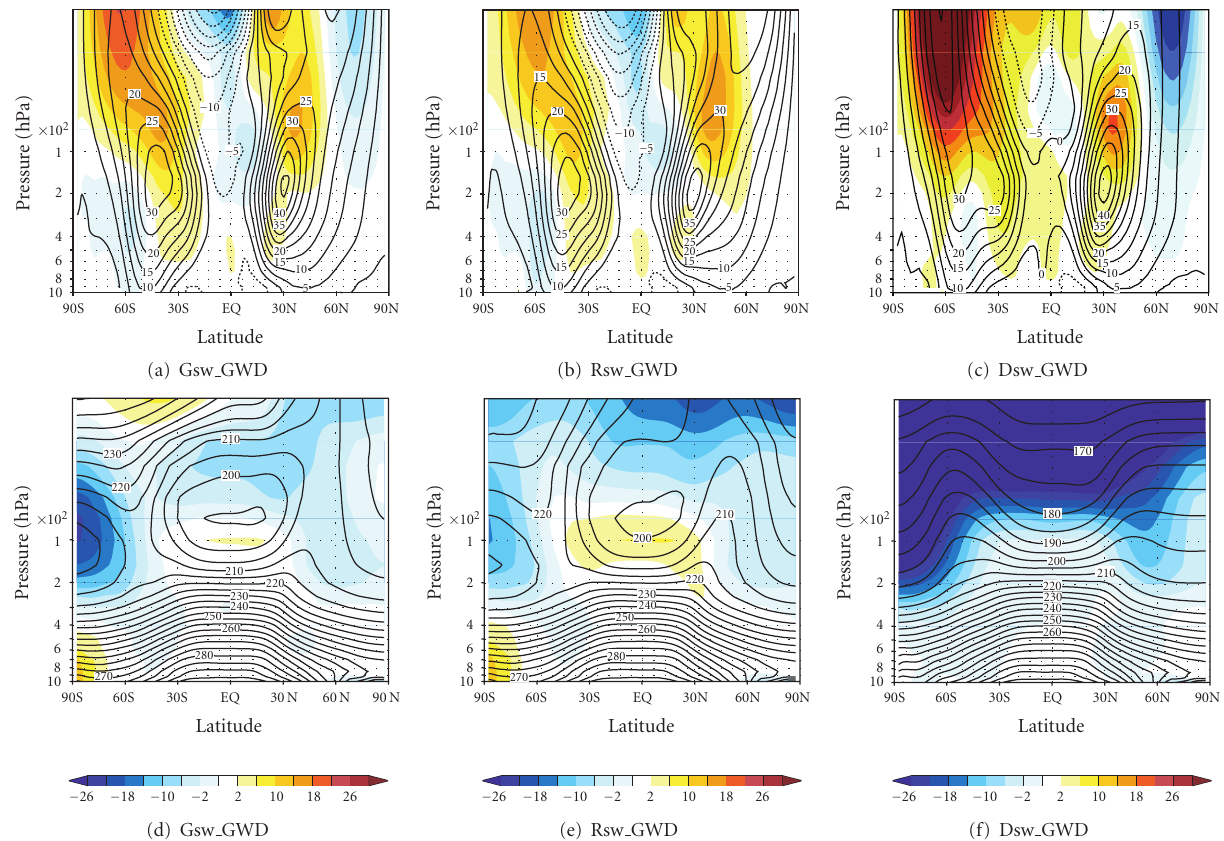
Figure 2: As in Figure 1, but with the new version of global WRF including the KA GWDO parameterization.